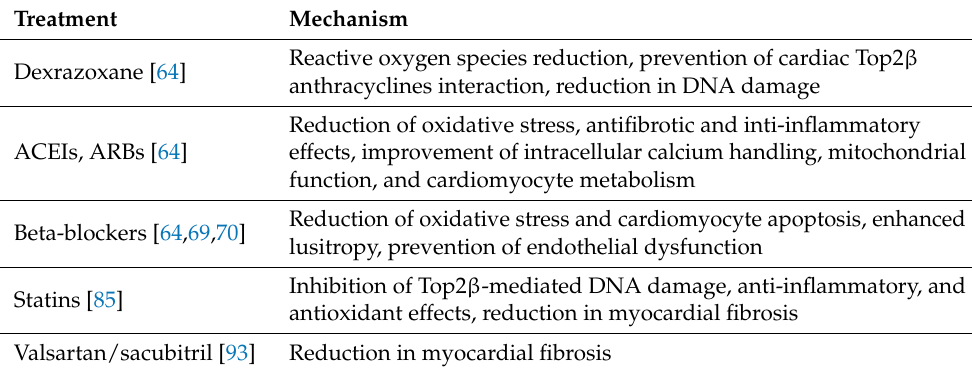
Table 4. Drugs protective against cardiotoxicity induced by